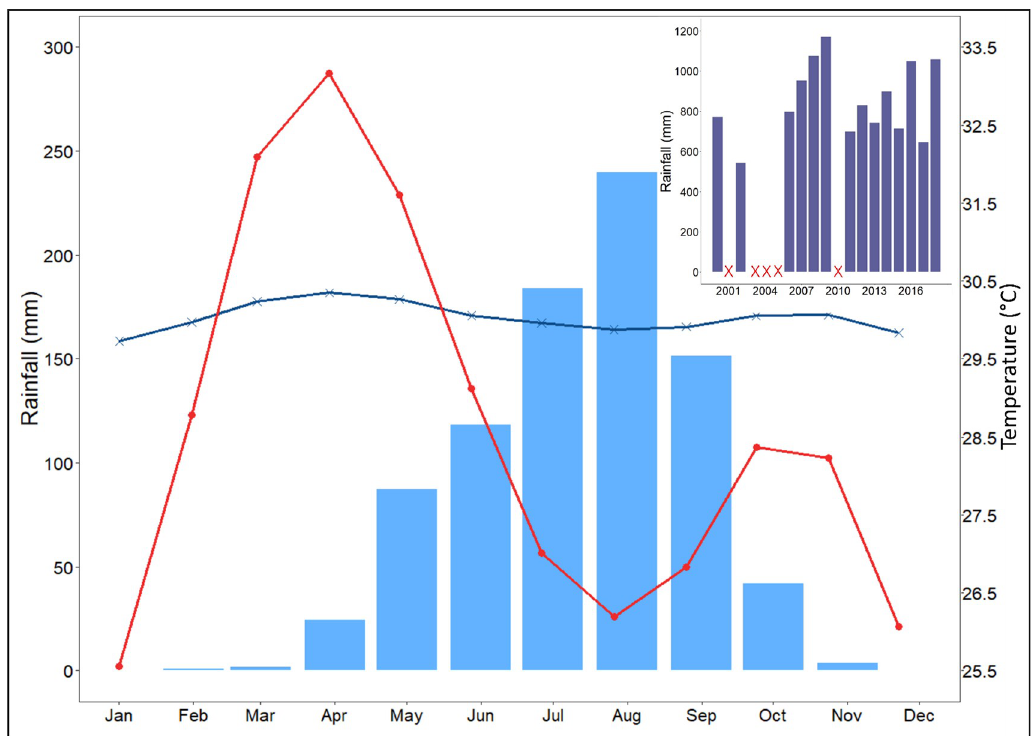
Fig 2. Average monthly rainfall for the period 2000–2018 (bar chart in blue, Tenkodogo station), air temperatures for the period 2000–2018 (red line with dots, Fada N’Gourma station) and satellite-derived surface water temperatures for the period 2000–2018 (blue line with crosses). Annual rainfall from 2000 to 2018 is shown in the inset (no data are available for 2001, 2003–2005 and